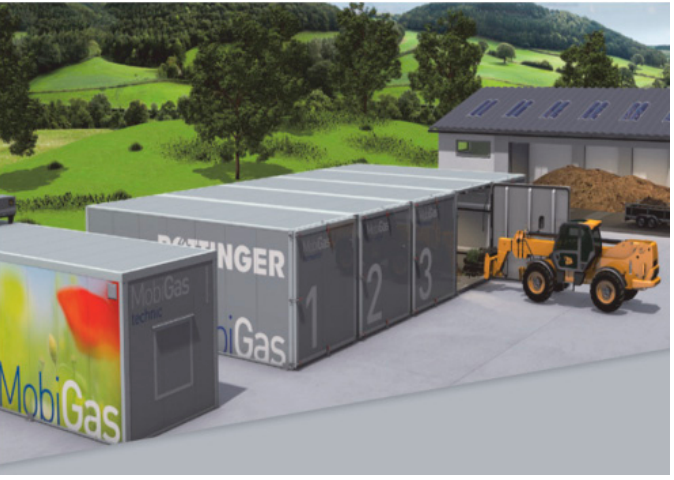
Figure 6. Simple garage type solid waste digesters [42].